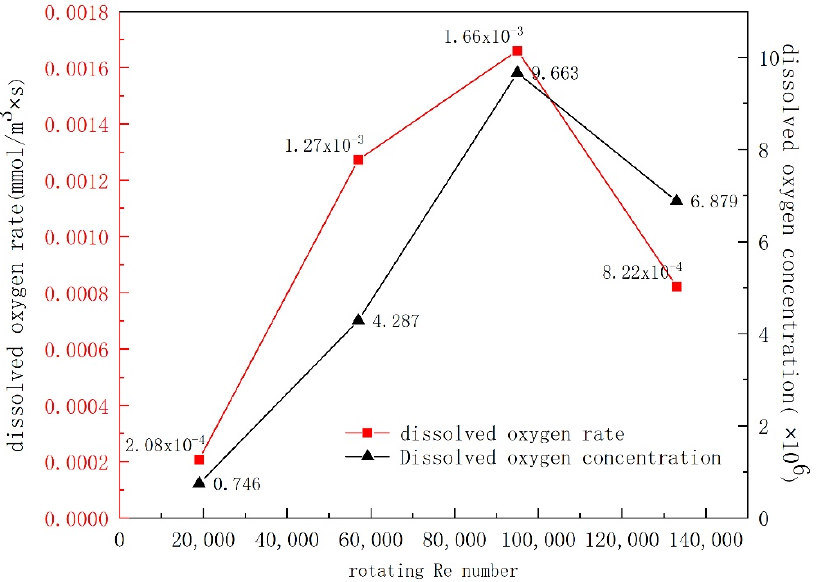
Figure 15. The dissolved oxygen rate and liquid oxygen content of the reactor under different rotating Re numbers.